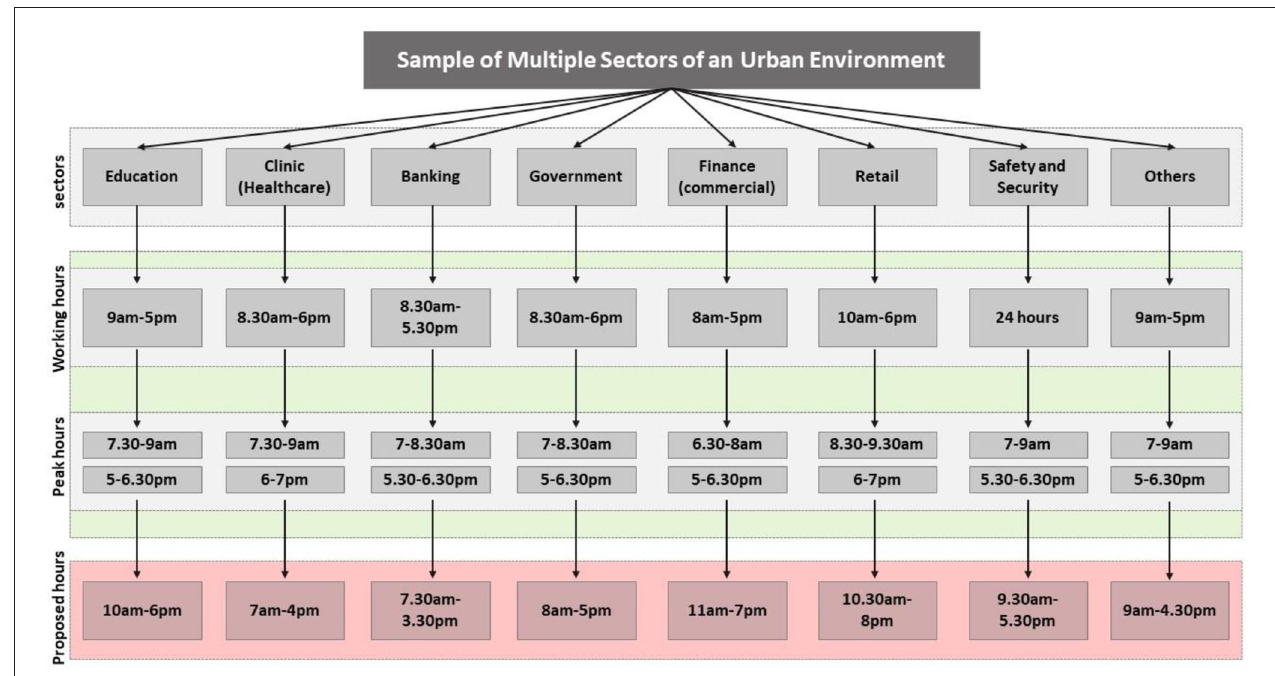
FIGURE 4 | Summary of multiple sectors, operational hours, peak hours, and proposed hours of operations (source: the authors).